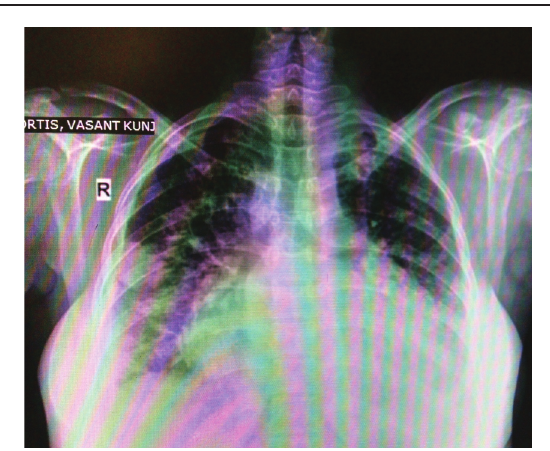
Computed tomography thorax showing bilateral pleural effusion with ground glass opacities and centrilobular